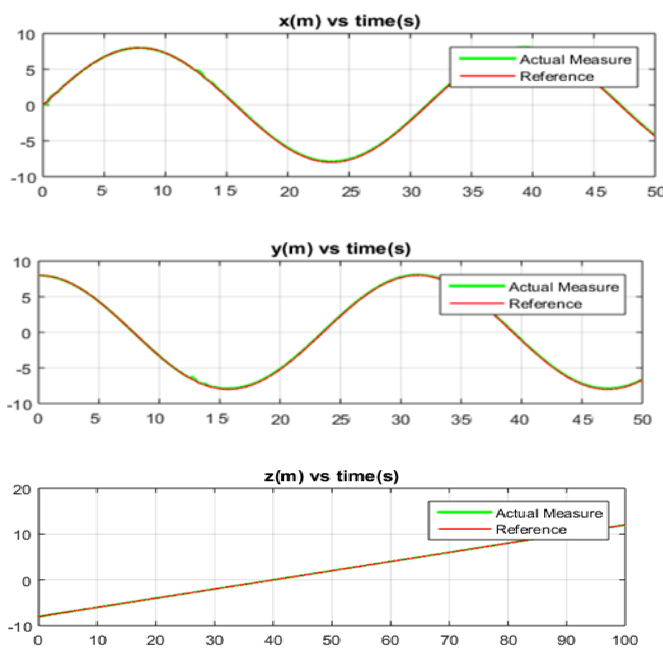
Figure 15. Position response derived using SDF-SMC control technique.